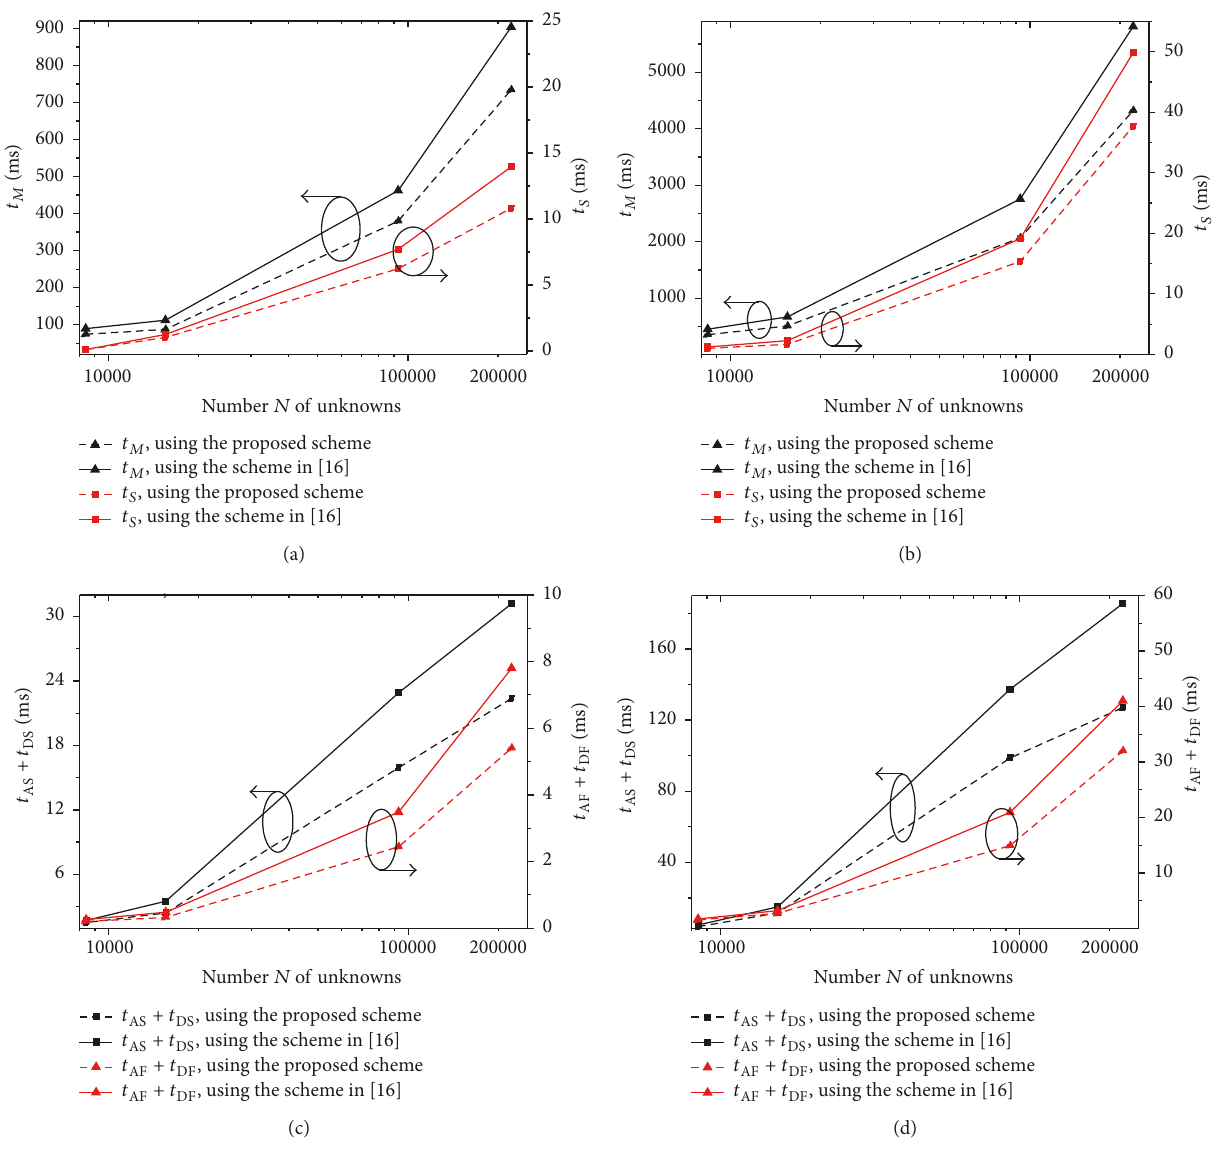
Figure 7: 𝑡 𝑀 and 𝑡 𝑆 as function of N with (a) single and (b) double precision; 𝑡 AF + 𝑡 DF and 𝑡 AS + 𝑡 DS as function of N with (c) single and (d) double